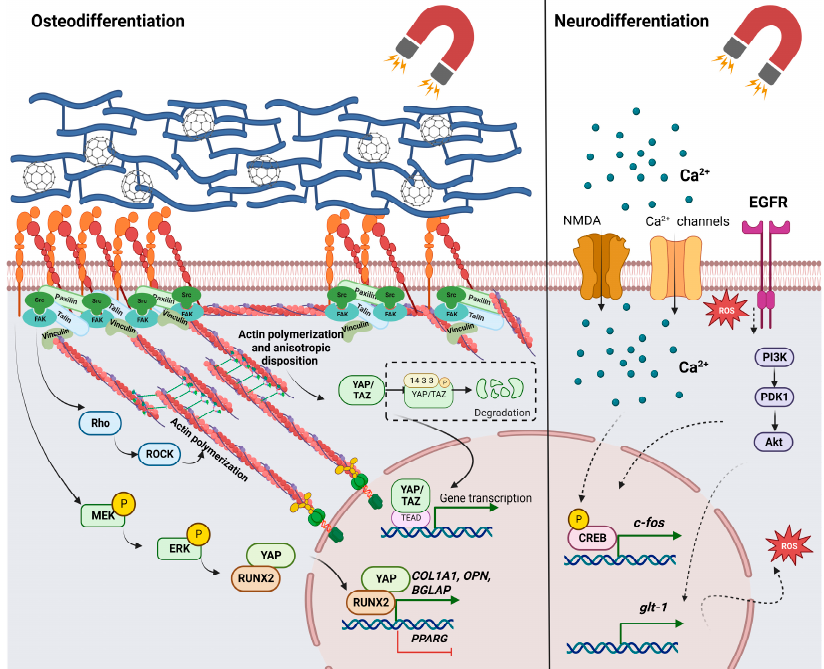
Figure 3. Signaling pathways associated with stem cell differentiation in response to magnetic ma- terials and magnetic fields. Abbreviations: protein kinase B—Akt; bone gamma-carboxyglutamate protein—BGLAP; calcium ions—Ca 2+ ; cAMP response element-binding protein—CREB; collagen